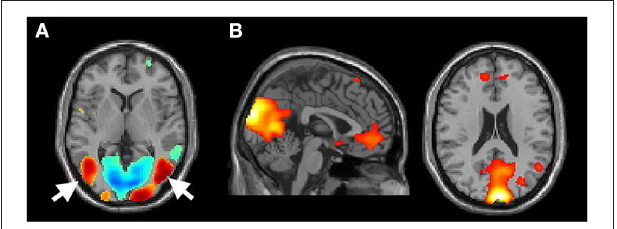
FIGURE 2 | (A) Activation of the MT/V5 area (arrow) of participant 11 (P11) while performing the motor imagery task during fMRI and (B) activation of the default mode (from the excluded